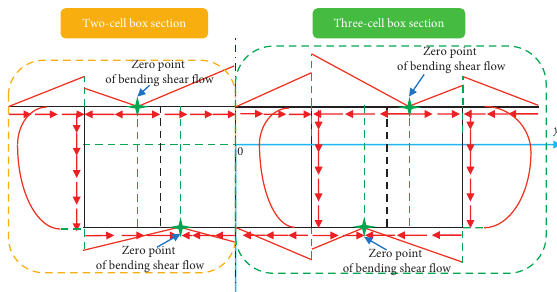
Figure 2: Bending shear flow in the single-box multicell box